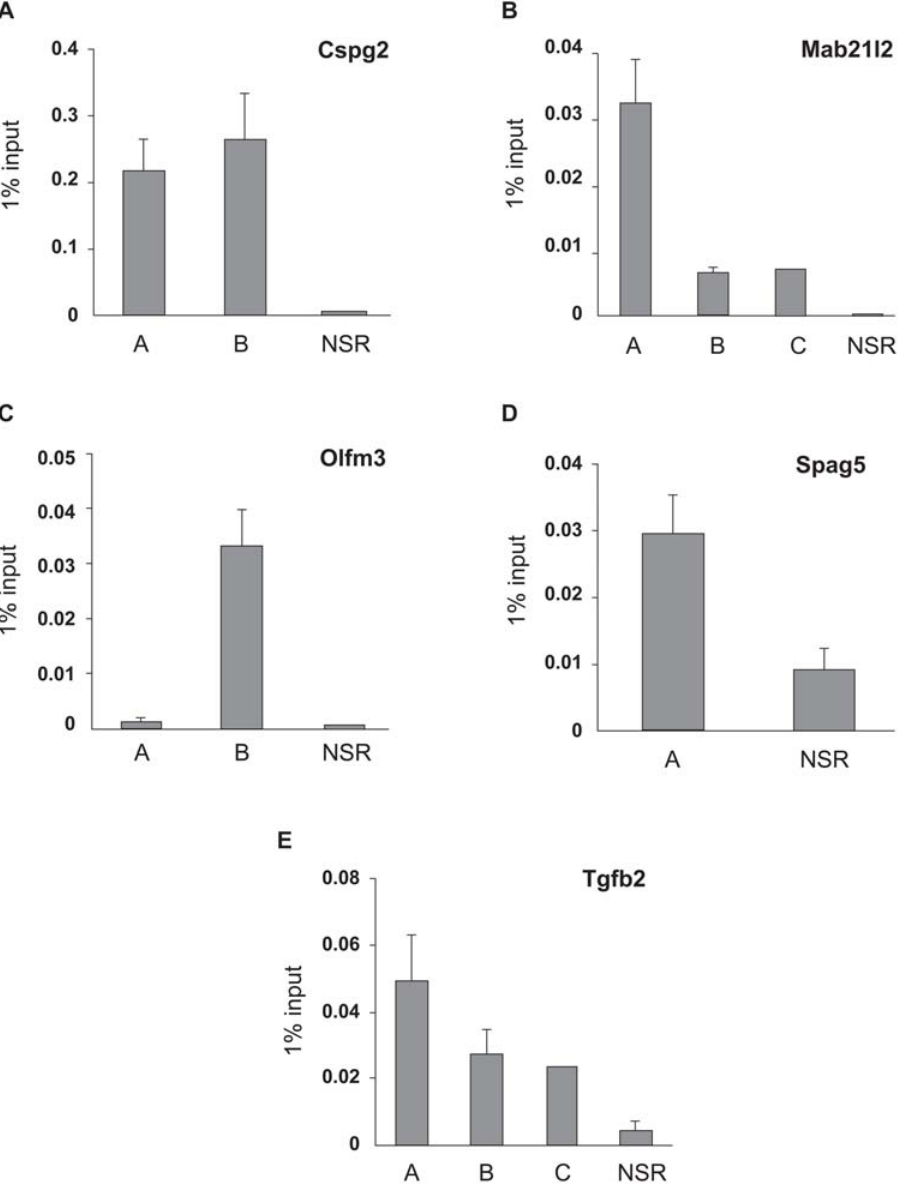
Figure 6. Validation of Pax6-binding to Cspg2 , Mab21l2 , Olfm3 , Spag5 , and Tgfb2 loci by qChIP. A) Confirmation of Pax6-binding in the promoter and 5 kb distal region of Cspg2/Vcan locus in lens chromatin. B) Confirmation of Pax6-binding in three regions (both 5 9 and 3 9 of the start site of transcription) of Mab21l2 locus in lens chromatin. C) Confirmation of Pax6-binding in the promoter of Olfm3 locus in lens chromatin. D) Confirmation of Pax6-binding in the promoter of Spag5 locus in lens chromatin. E) Confirmation of Pax6-binding in the promoter and 5 kb distal region of Tgfb2 locus in lens chromatin. The relative enrichments are shown as 1% of the input. The ‘‘peak’’ regions (A, B and C) and no-signal regions (NSR) are shown in Supporting Information.